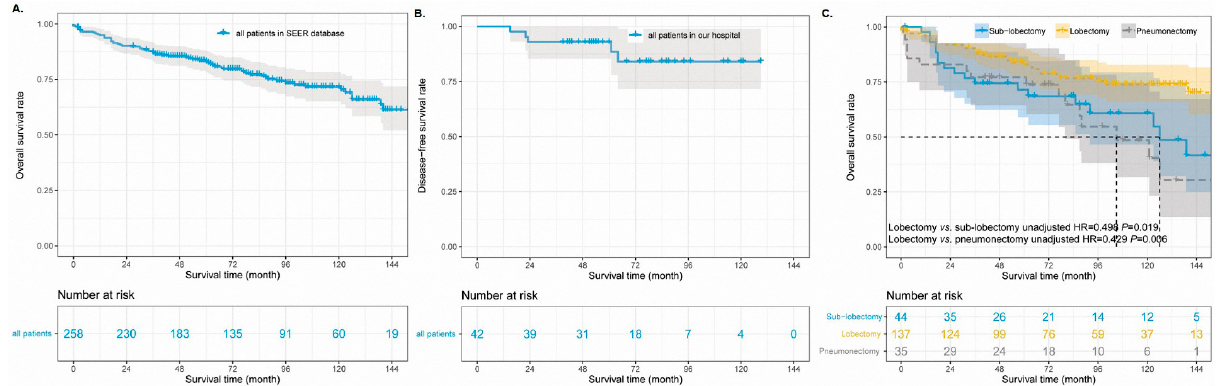
Figure 4. The unadjusted survival curves of for patients who underwent surgery in the SEER database ( A ) and Shanghai Pulmonary Hospital ( B ). The adjusted survival curves of different surgical types ( C ). SEER: Surveillance, Epidemiology, and End Results. Table 4. Univariable and multivariable Cox proportional hazard regression analyses of postopera- tive prognostic factors in salivary gland-type carcinoma patients.